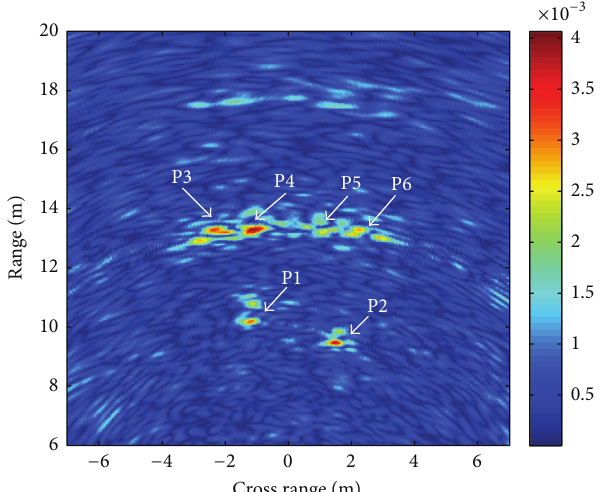
Figure 14: The original moving target imaging result. There are six targets in the image, including two true targets and four